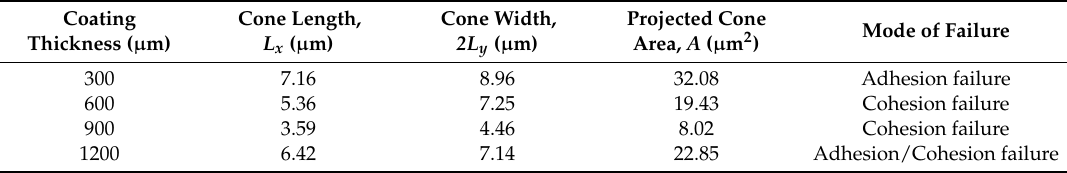
Figure 7. SEM image showing cone formation (coating thickness: 1200 µ m). Table 1. Summary of parameters obtained from SEM after nanoscratch.